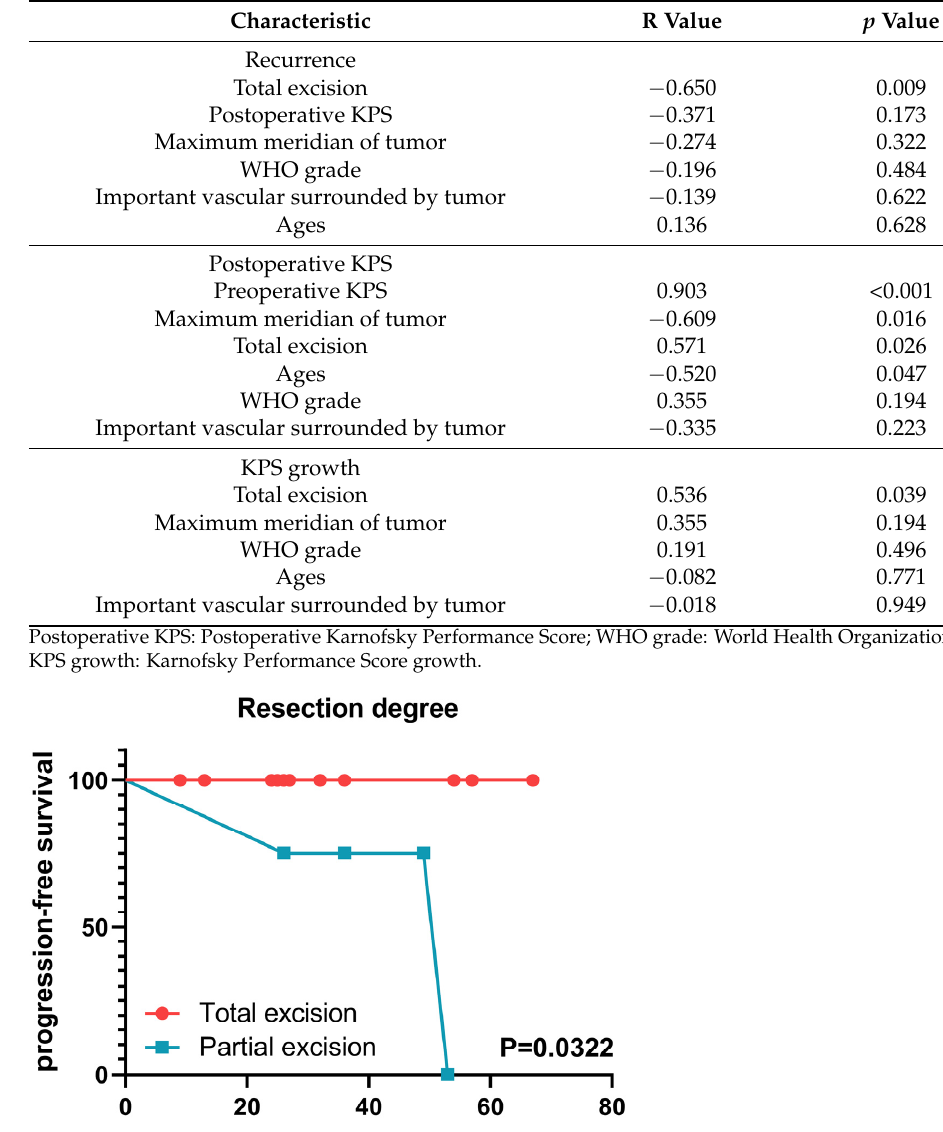
Table 4. Spearman correlation analysis of prognosis and KPS related factors.